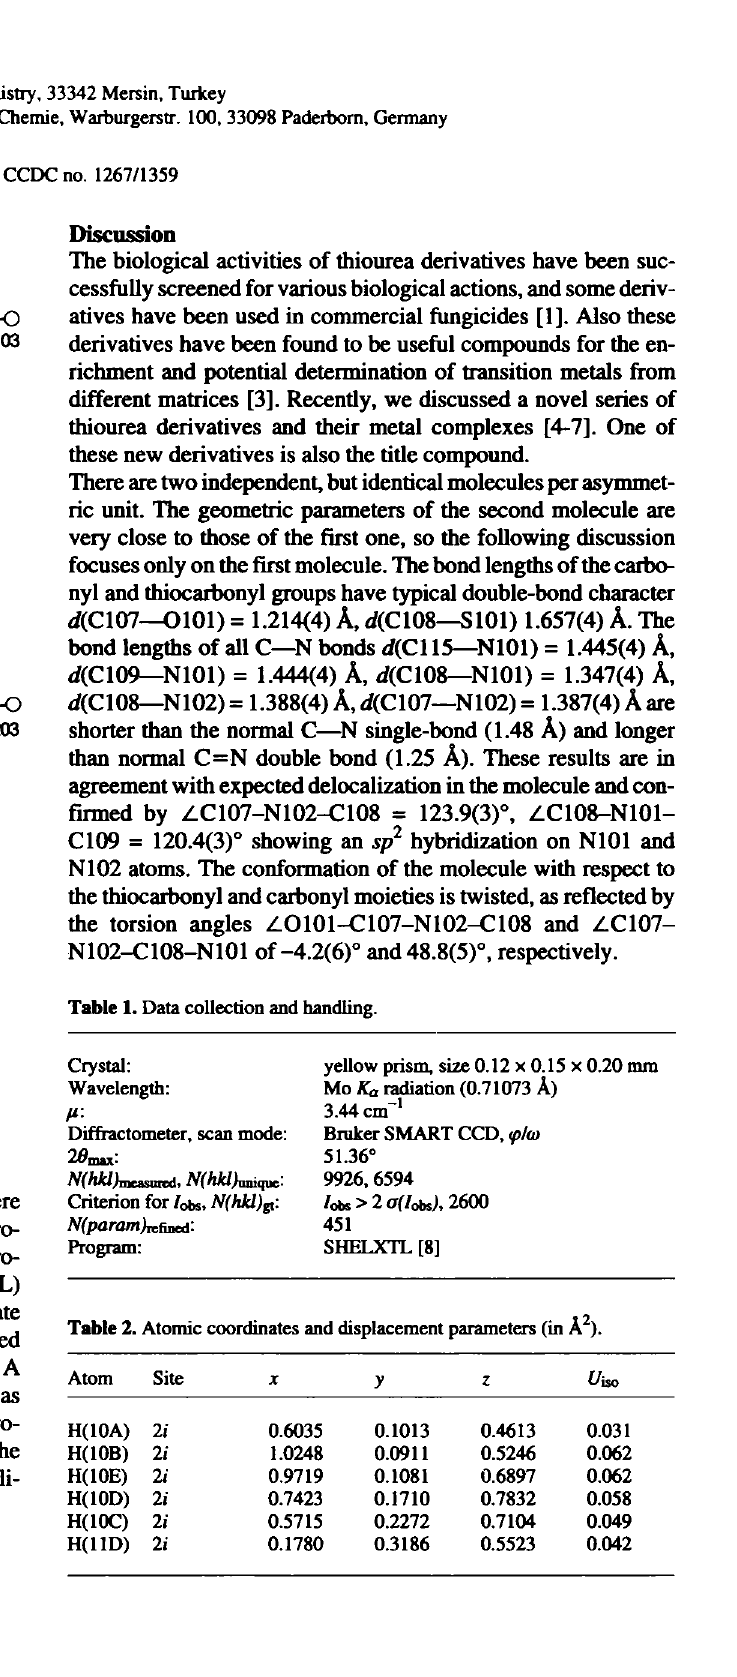
Table 2. Atomic coordinates and displacement parameters (in Â 2